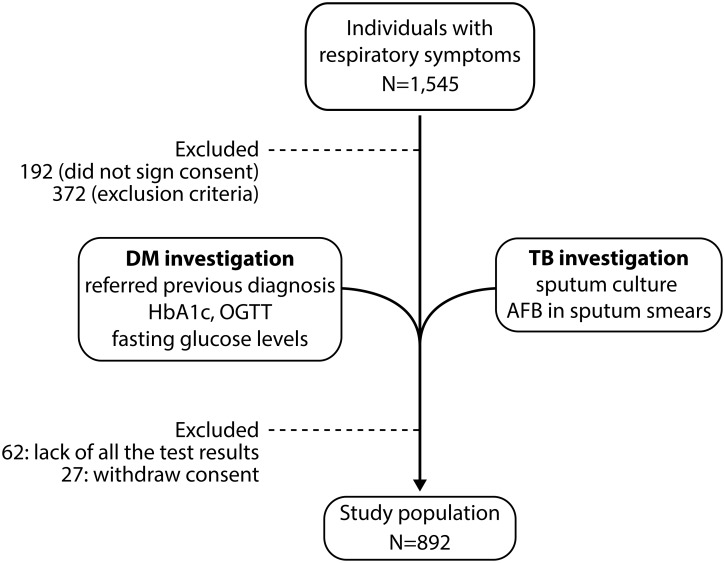
Overall study design.Individuals presenting with respiratory symptoms (n = 1,545) were recruited at a TB primary care reference center in Brazil. In two consecutive visits (1–3 days apart), all individuals were screened for diabetes / glucose metabolism disorder in the clinical interview and with laboratory tests (glycated hemoglobin, HbA1c; oral glucose tolerance test, OGTT; fasting glucose levels). Individuals were simultaneously tested for pulmonary TB by identification of acid-fast bacilli (AFB) in sputum smears and positive sputum culture for Mycobacterium tuberculosis. Details of the study design and patient population are described in Methods.